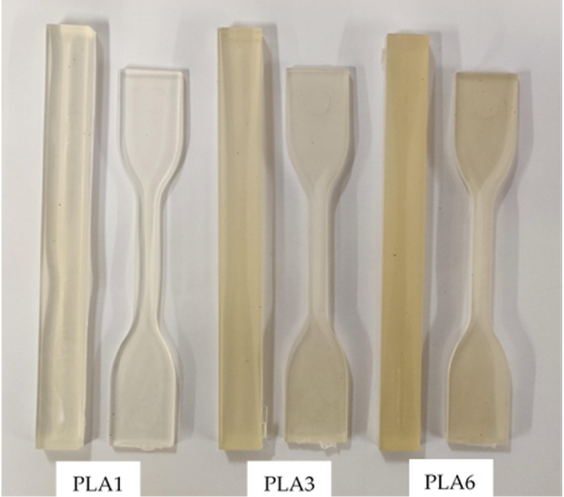
Figure 4. Injection-molded samples of PLA post 1, 3 and 6 recycling steps. The samples are noticeably more yellow with respect to increased recycling steps.